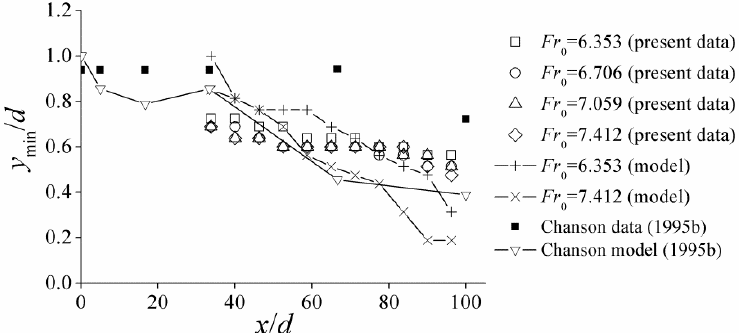
Figure 5. Comparison between experimental data and calculated results for the development of air bubble diffusion to the channel bottom.